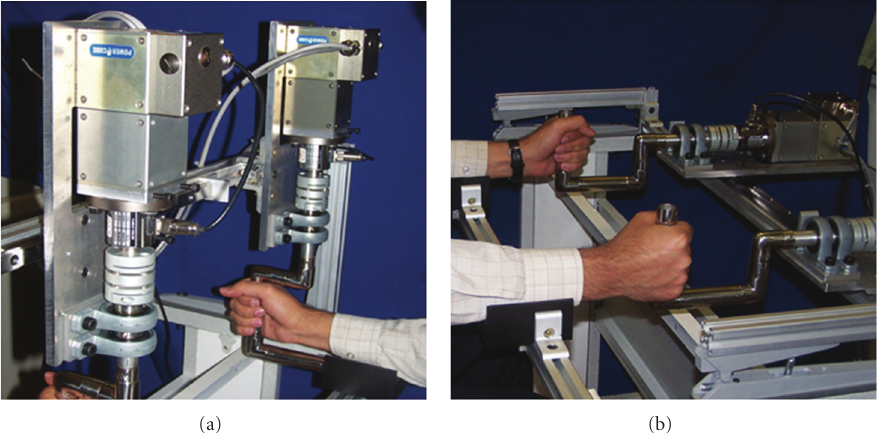
Figure 14: Hand robotic rehabilitation device. (a) Wrist flexion and extension. (b) Forearm pro-and supination. Reprinted with permission.